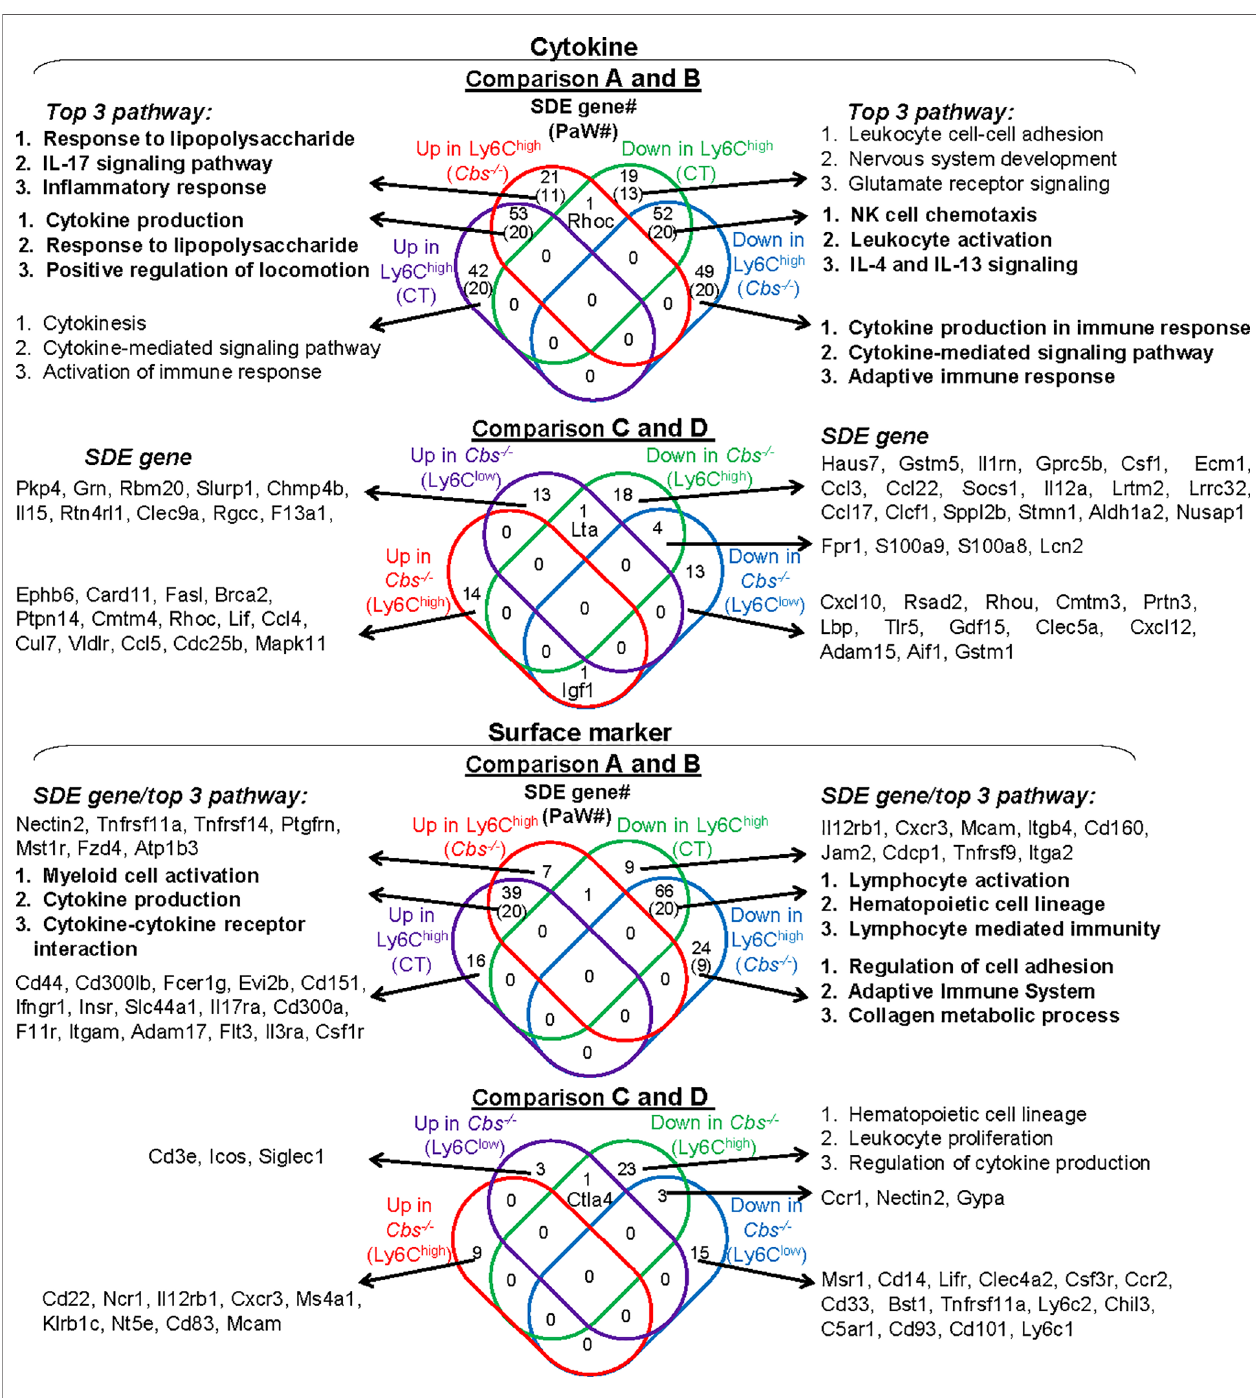
FIGURE 4 | Immunological signature genes and top functional pathways in Ly6C MC subset from CT and Cbs -/- mice. (A) Identi fi cation of immunological SDE genes (secretome, cytokine and surface marker). Volcano plot of all genes demonstrates the expression pattern of SDE genes in four comparison groups. Down- regulated SDE genes are highlighted in green and up-regulated in red (|Log 2 FC|>1, adj. P<0.01), with Log 2 FC as x-axis and − Log 10 (adjust P -value) as y-axis. SDE secretome, cytokine and surface marker were identi fi ed using the immunological gene set established in our previous study (PMID: 32179051) from website (https:// www.proteinatlas.org/). Top 25 up- and down-regulated SDE genes in all comparisons via IPA are listed in Supplementary Table 2 . (B) Overlap analysis for SDE immunological genes in Ly6C MC subsets and top pathways. Venn diagram summarized the total SDE genes and their top three pathways in each SDE set from four pairs of comparisons. Functional pathways were developed by metascape software mainly using the GO database only in SDE set (>20 SDE genes). The top 3 functional pathways are presented. Numbers depict the amount of SDE genes. Numbers in the parentheses describes the number of pathways. A detailed list of SDE genes and pathway in each SDE set are presented in Supplementary Table 3 . ECM, extracellular matrix; EC, extracellular; IFN g , interferon gamma; MNC, mononuclear cell; NK, natural